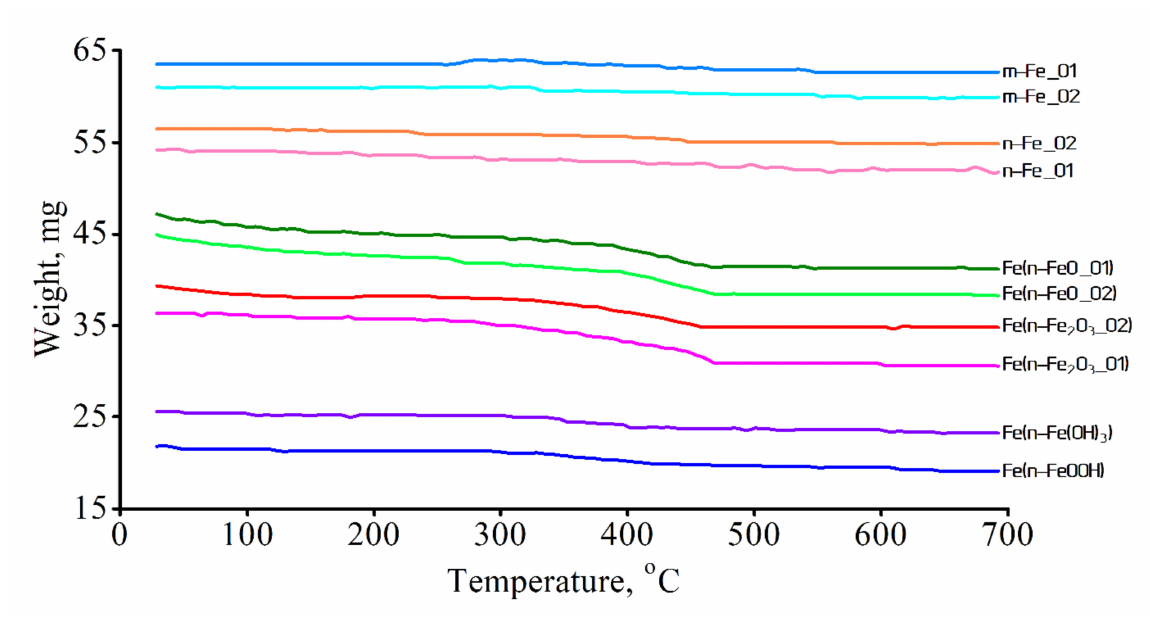
Figure 6. TGA analysis of iron